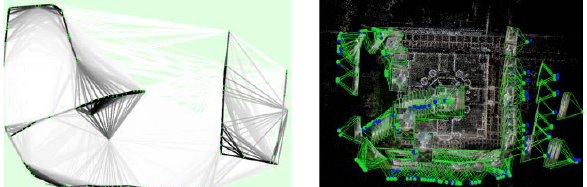
Figure 12: Image connectivity (left), tie point cloud and camera locations (right), all UAV images